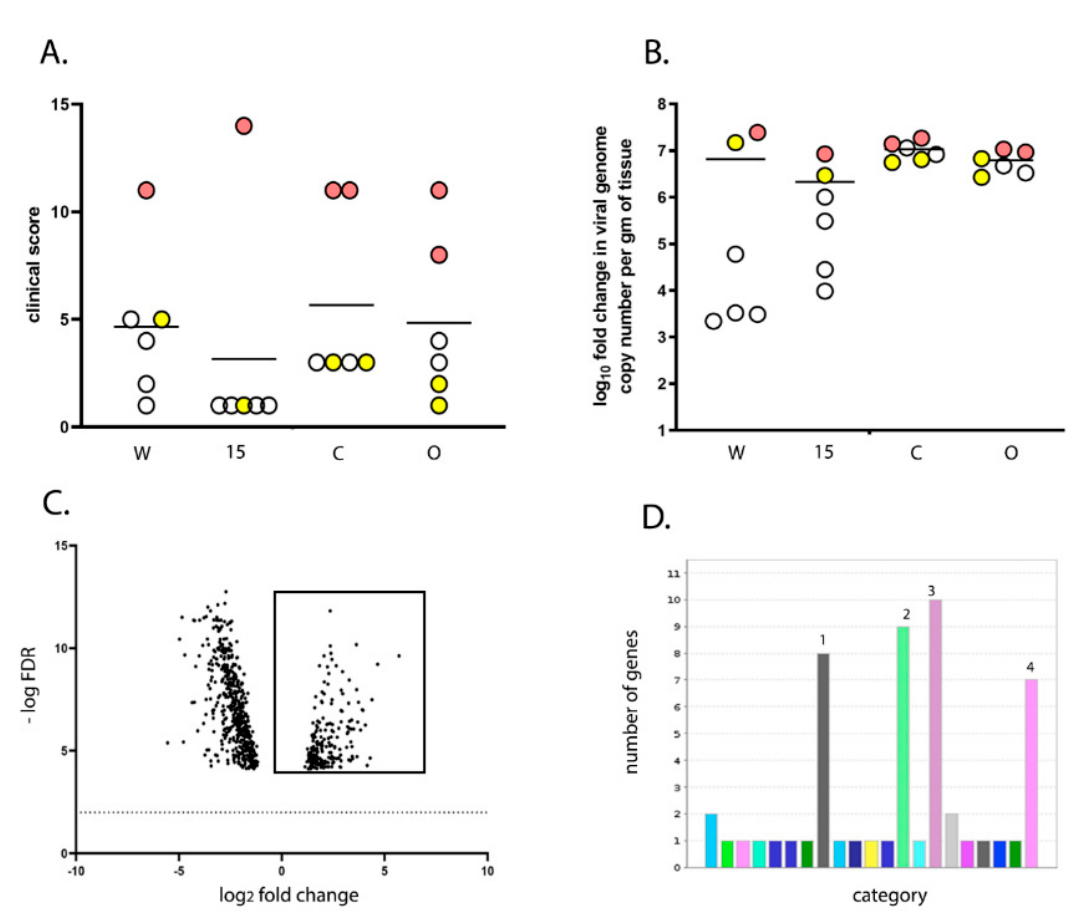
Figure 4. Birds with a high clinical score showed up-regulation of pathways involved in inflammation mediated by chemokine and cytokine signaling, cytoskeletal regulation by Rho GTPases, nicotinic acetylcholine receptor signaling, and Wnt signaling in the BF compared to birds with a low clinical score. The transcriptional profile of 6 birds with a “high clinical score” (8–14; pink dots) was compared with that of 6 birds with a “low clinical score” (1–5; yellow dots) at 3 dpi, with low clinical score as a baseline. Both the high and low clinical score groups consisted of one bird from line W, one from line 15, two from line C and two from line O ( A ), and there was no significant difference in the average viral replication between the two groups ( B ). RNA was extracted from the BF of the birds and subjected to RNA-seq. The expression of the target genes was reported as fold-change (FC), with values ≥ 2 considered as up-regulated, and values ≤− 2 considered as down-regulated. The false discovery rate (FDR) was calculated and a volcano plot of − log FDR over log2 FC plotted; FDR values of ≤ 0.05 were considered as significant. Each dot represents one gene and genes meeting the cut-off criteria for FC and FDR, therefore considered as up-regulated in birds with a high clinical score compared to a low clinical score are boxed ( C ). Pathway analysis of the selected genes with Protein ANalysis THrough Evolutionary Relationships (PANTHER) revealed four pathways that were significantly up regulated: 1 (grey)- inflammation mediated by chemokine and cytokine signaling, 2 (green)- cytoskeletal regulation by Rho GTPases, 3 (purple)- nicotinic acetylcholine receptor signaling, and 4 (pink)- Wnt signaling ( D ).